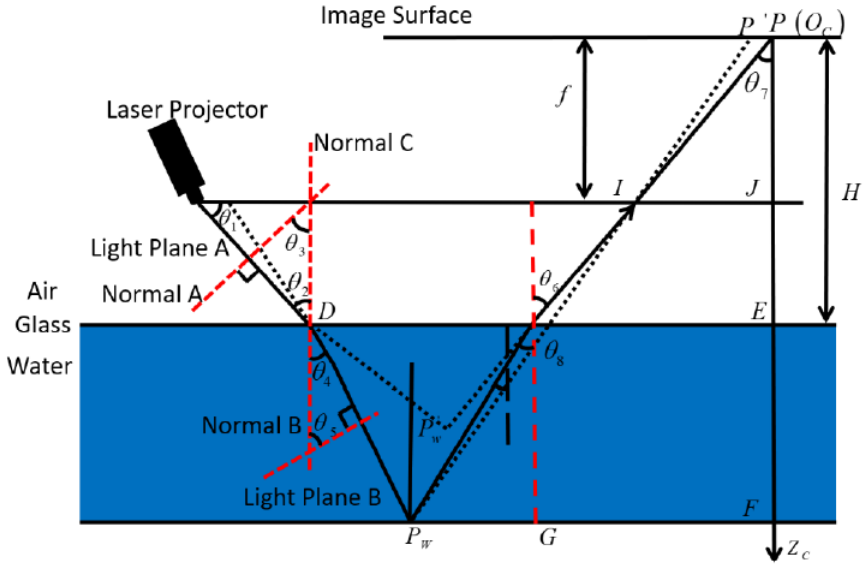
Figure 4. Refraction caused by watertight